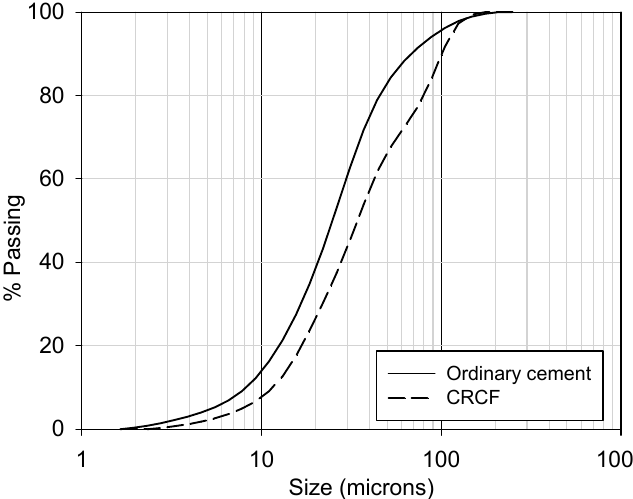
Figure 3. Particle size distributions of the original materials.